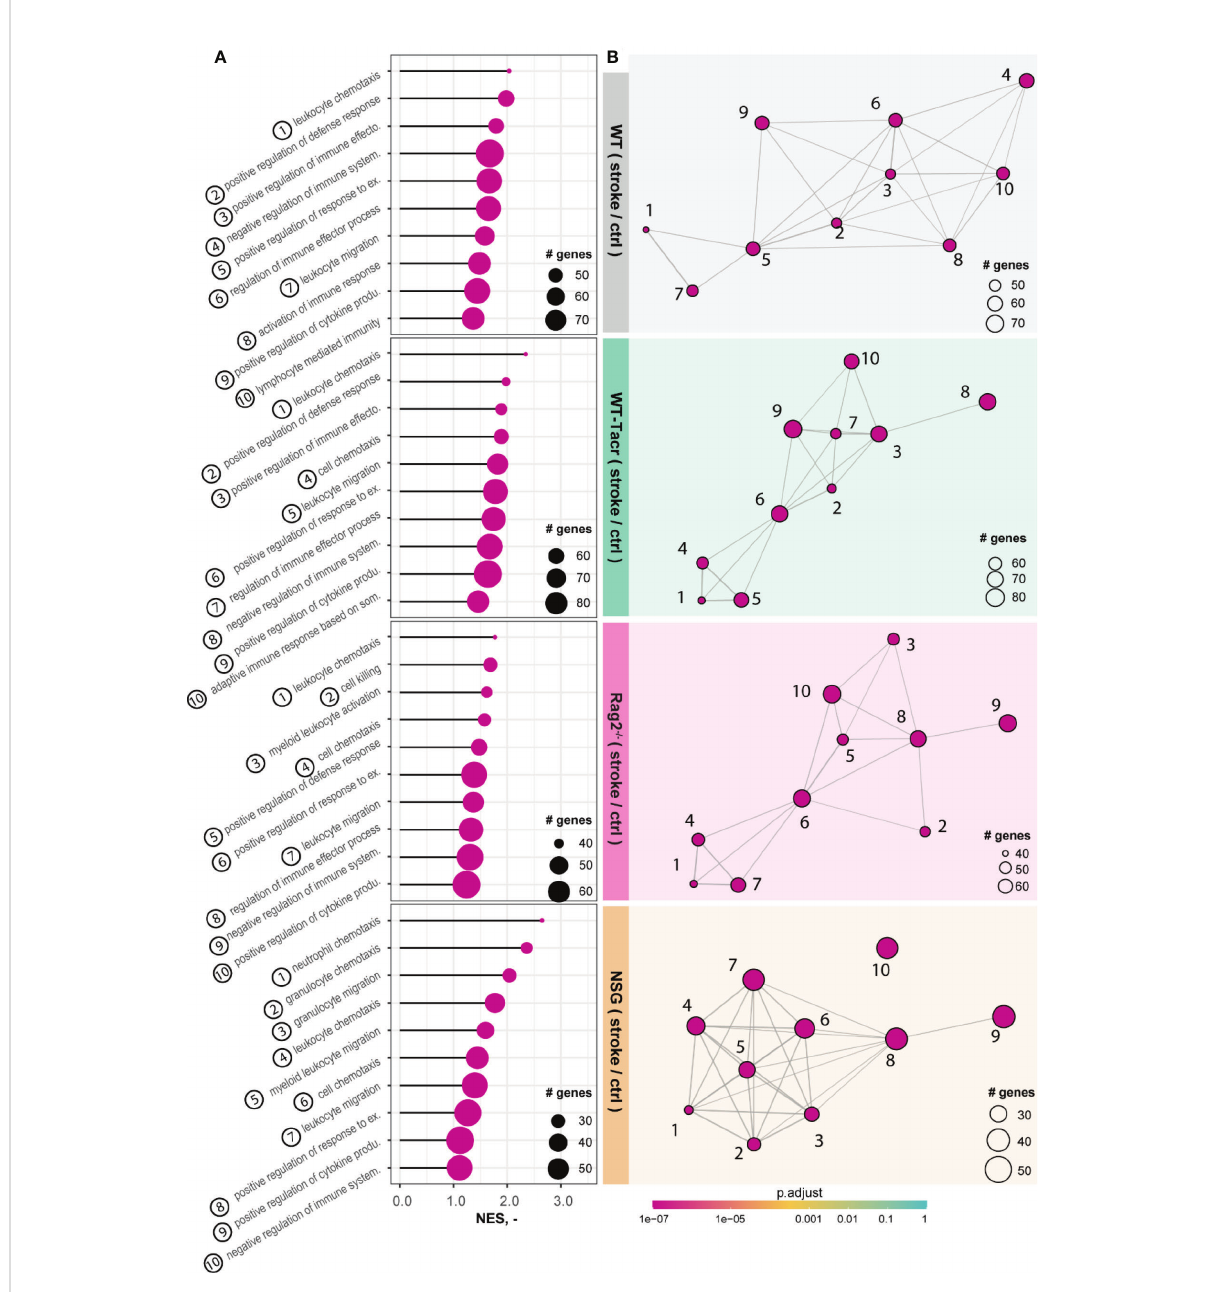
FIGURE 5 Gene set enrichment analysis in stroked mice. (A) Lollipop plot and (B) enrichment map (EMAP) of top 10 pathways enriched in stroked C57BL/ 6J wildtype (WT), tacrolimus immunosuppressed wildtype (WT-Tacr), recombination activating gene 2 de fi cient mice (Rag2 – / – ) and NOD scid gamma mice (NSG). mice compared to their non-stroked littermates. Size of dots represents the number of genes in the pathway and color of dots represents adjusted p